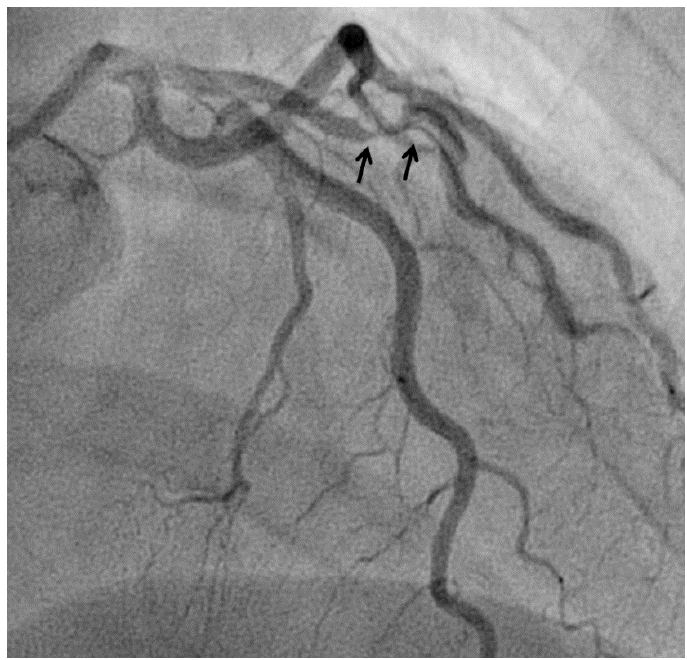
Figure 3. Spontaneous dissection (arrows) in a 45-years old woman causing non-ST elevation myocardial infarction.